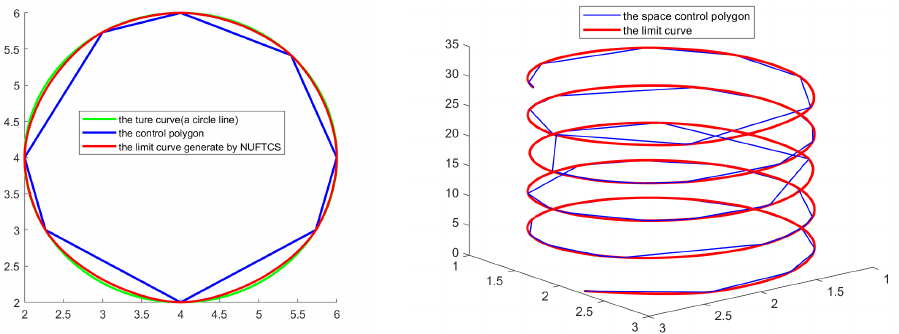
Figure 16. Subdivision curve with different control polygons. Left: planar control polygon (blue solid line); the red curve is the limit curve with NUFTCS, and the green curve is the real curve. Right: the space control polygon with 40 points, and the limit curve of the space control polygon generated by NUFTCS.